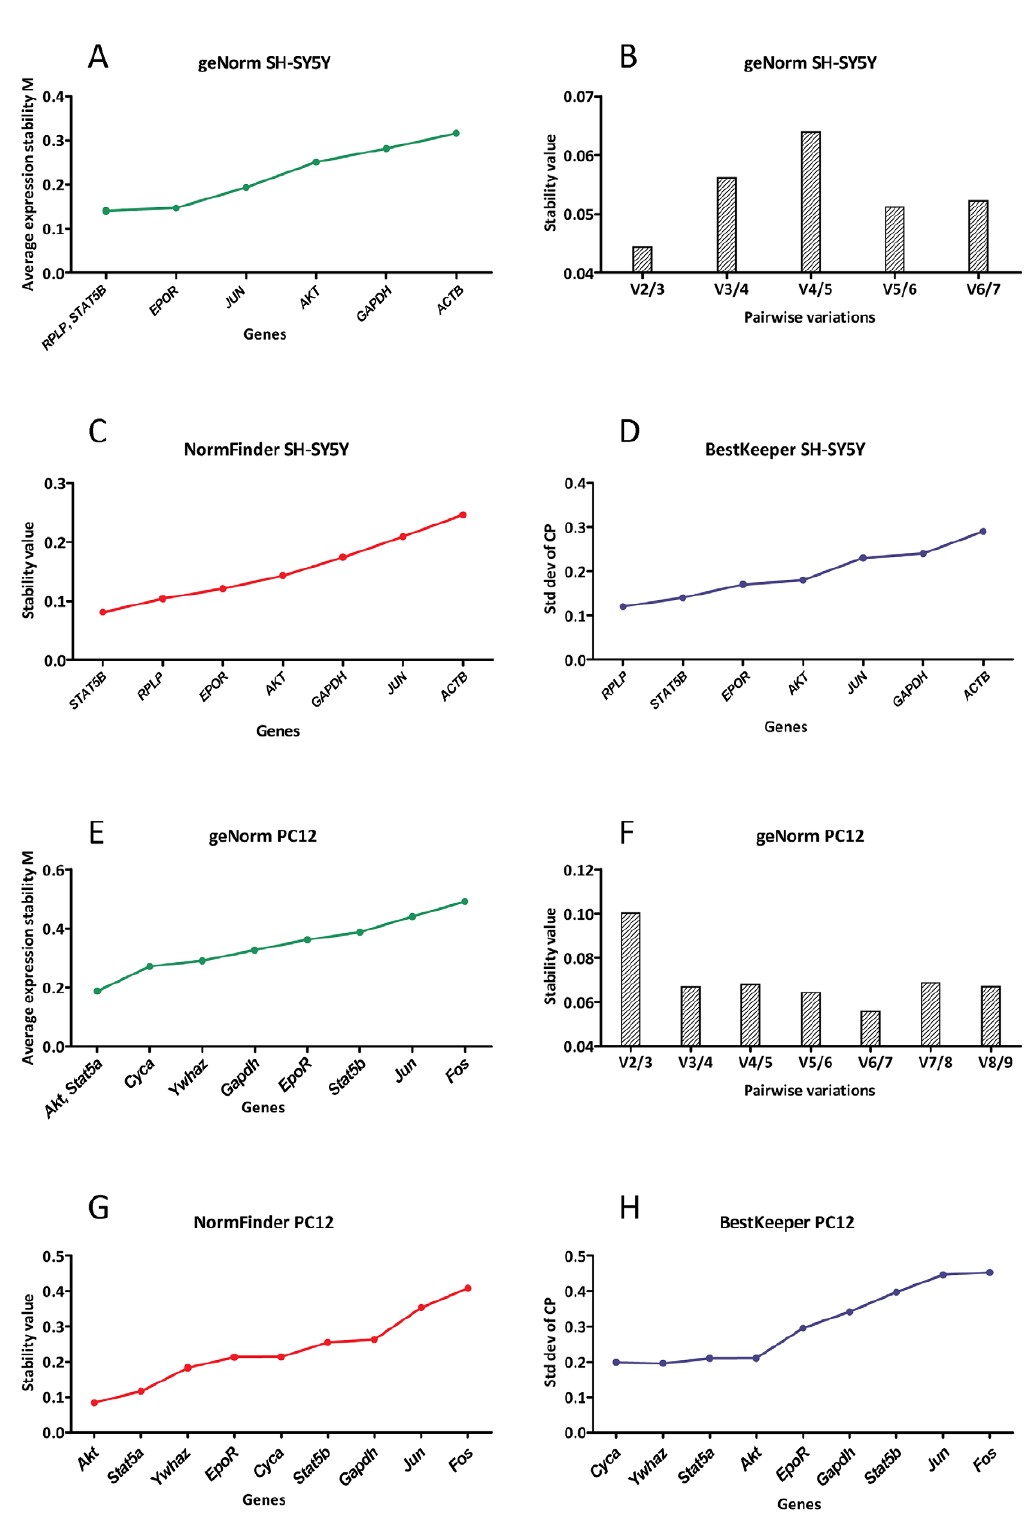
Figure 2. GeNorm, NormFinder and BestKeeper analysis of expression